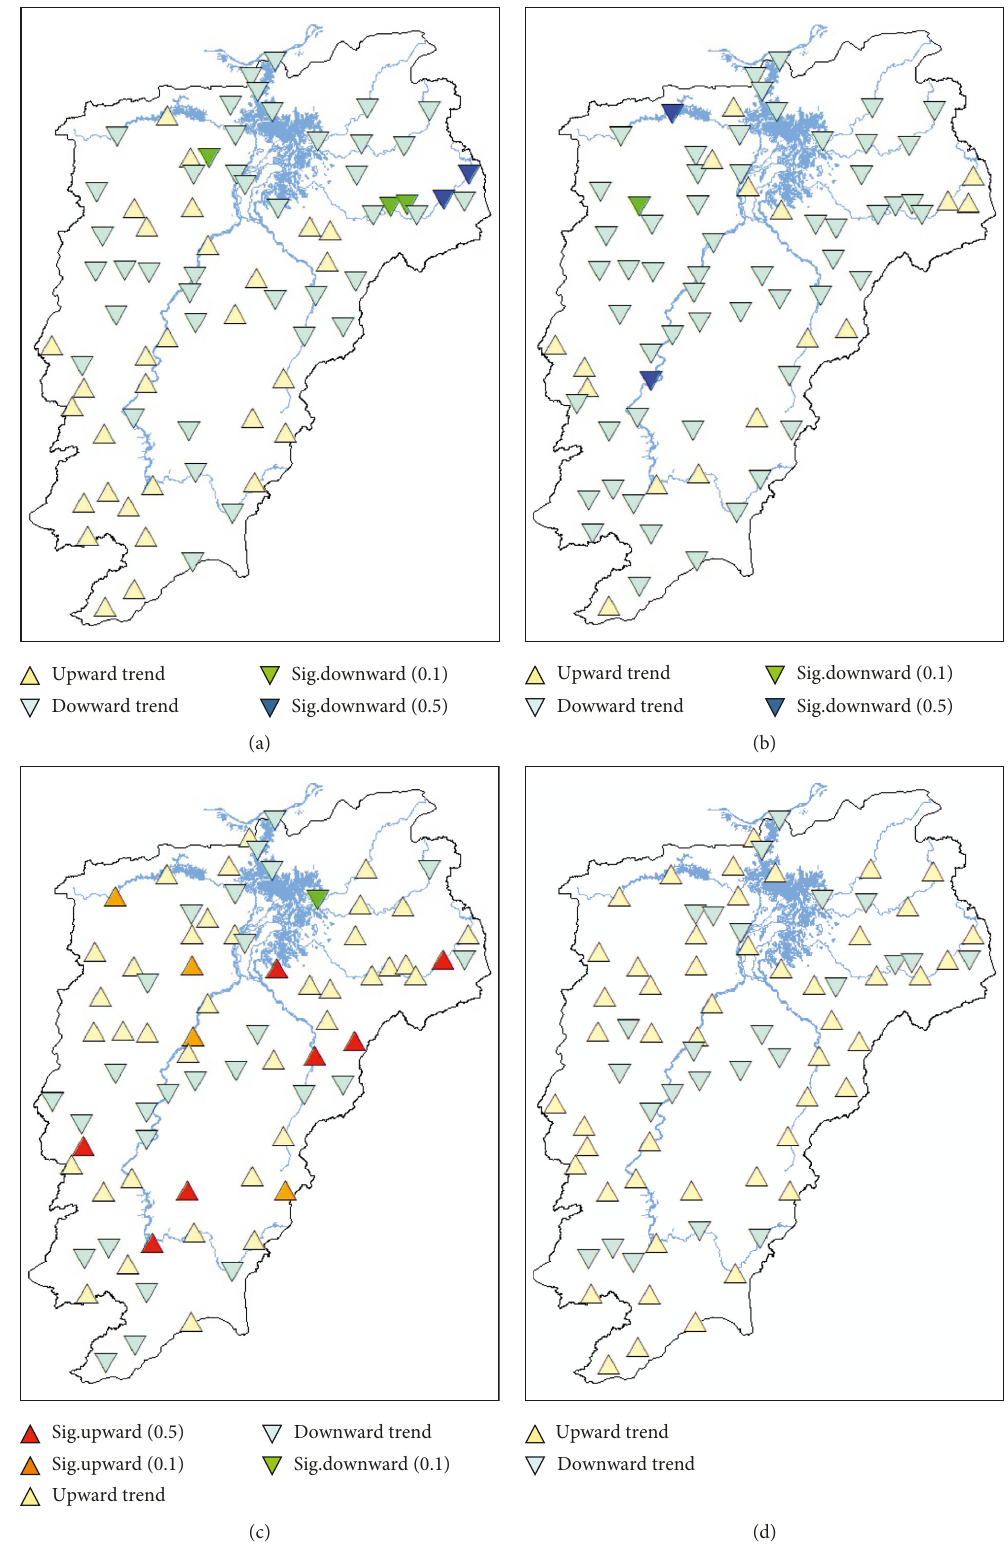
Figure 7: Spatial patterns of long-term trends for (a) CDD, (b) CWD, (c) Rx1d, and (d) Rx5d in the Poyang Lake basin during